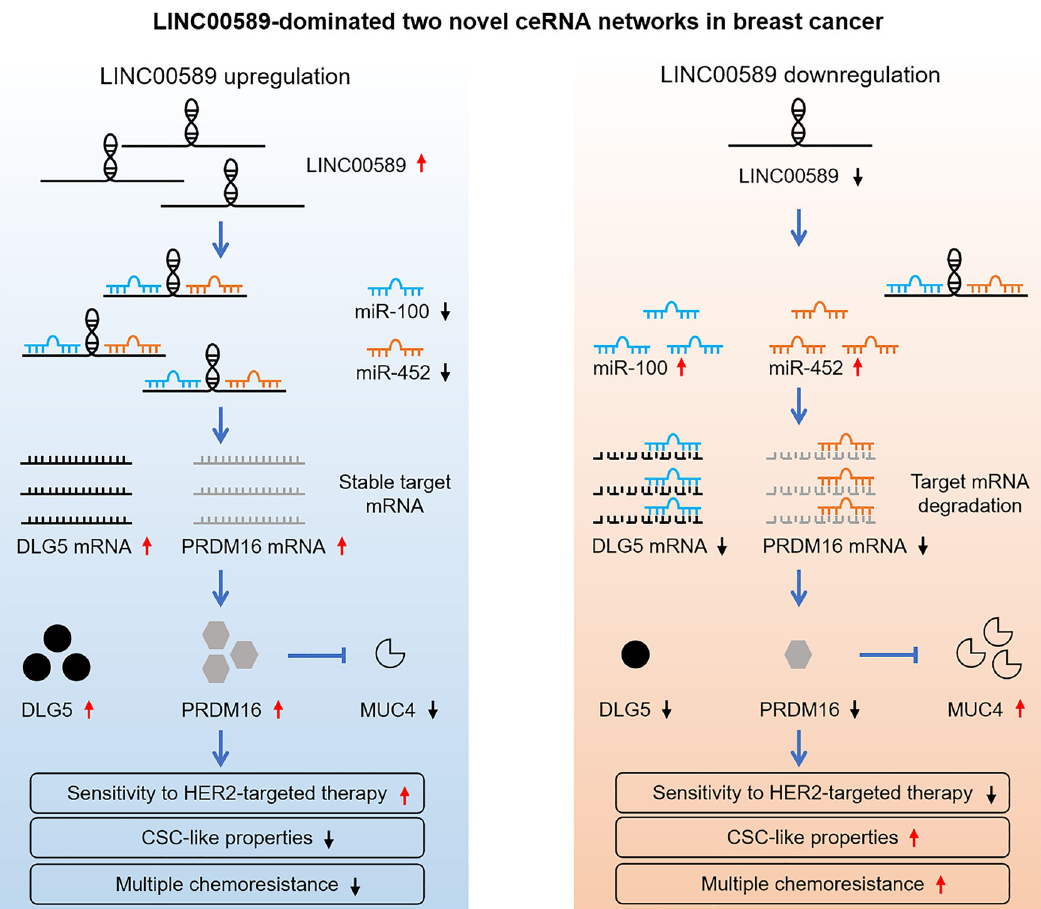
Fig. 10 Two LINC00589 -centered ceRNA networks in breast cancer. LncRNA LINC00589 serves as a ceRNA platform by sponging miR-100 and miR-452 and thereby relieves their repression of DLG5 and PRDM16 , which inhibits MUC4 transcription, resulting in counteractions of trastuzumab resistance, CSC-like properties, and multiple chemoresistance in HER2-positive breast